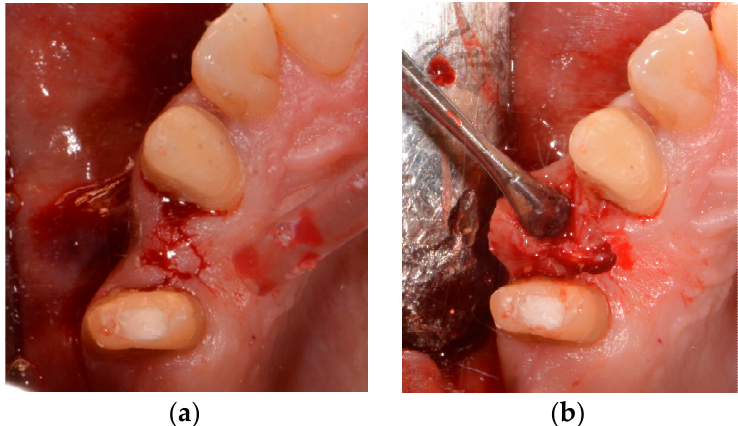
Figure 5. ( a ) Initial cut in region 14; ( b ) raising of the minimal mucoperiosteal flap in region 14 .